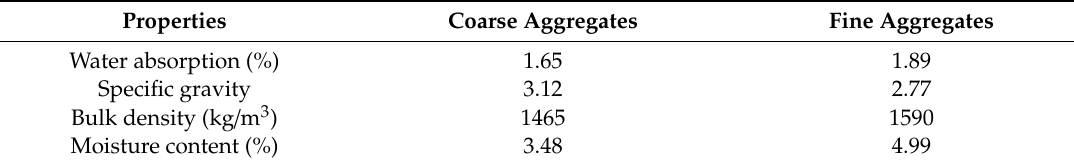
Figure 3. The particle size distribution for the used aggregates. Table 1. Measured properties of aggregates.